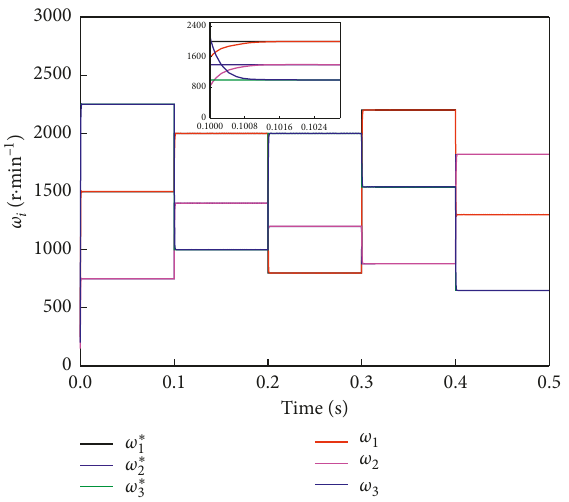
Figure 14: The velocity tracking curves of all servos under multiple cycles.